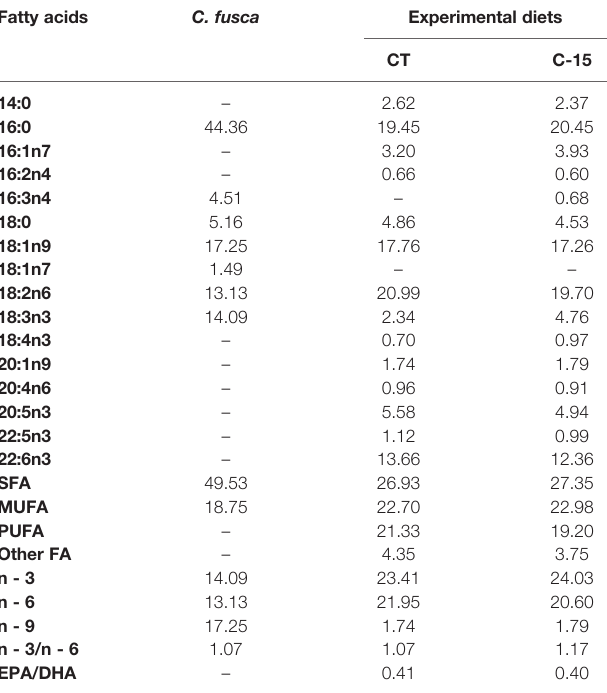
TABLE 2 | Fatty acid composition (% of total fatty acids) of microalga and experimental diets used in the feeding